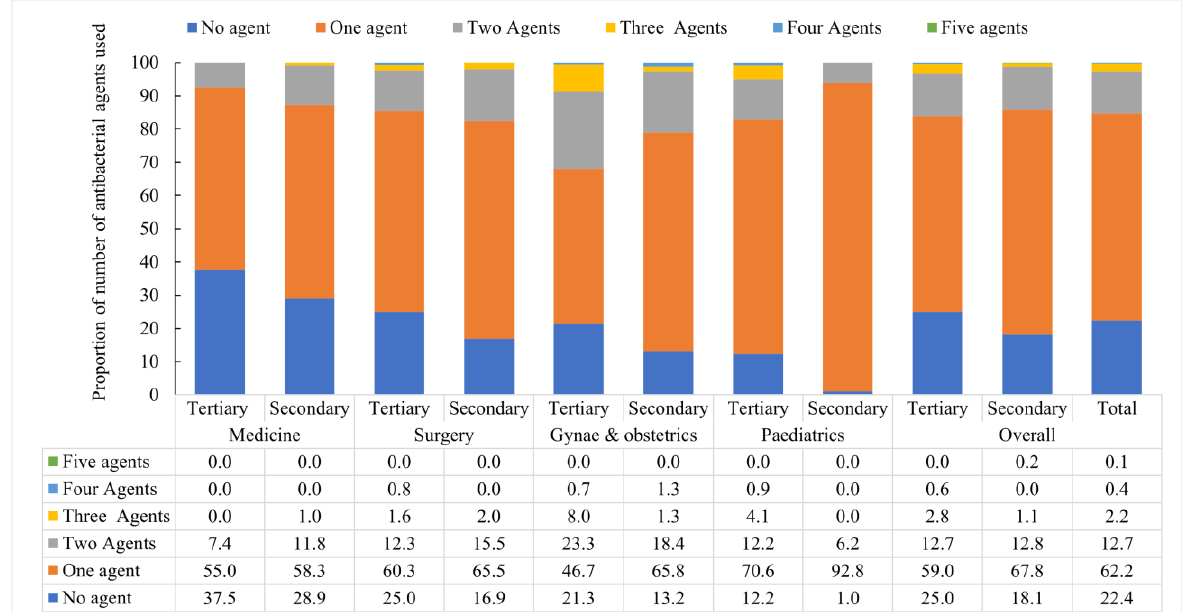
Figure 1. Number of antibacterial agents used for treating patients during hospitalization on the day of the point prevalence survey at different departments of tertiary and secondary level hospitals in Bangladesh from February to April